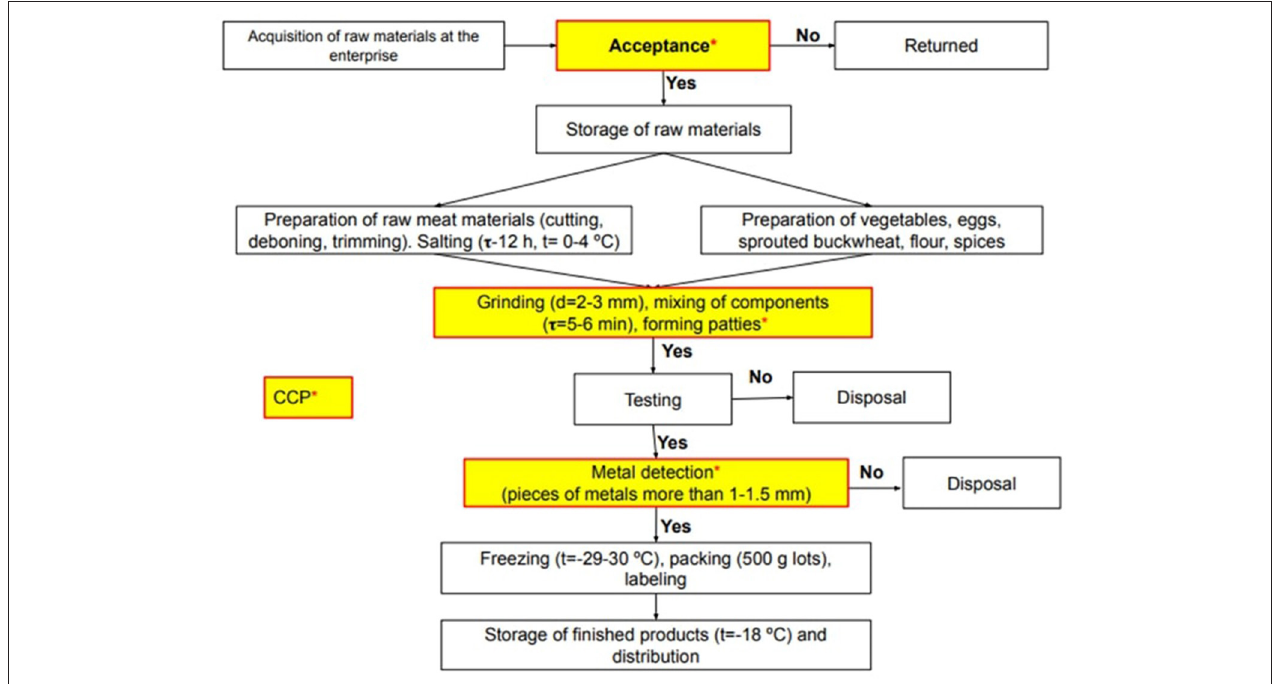
FIGURE 3 | Flowchart of the production of the combined meat product